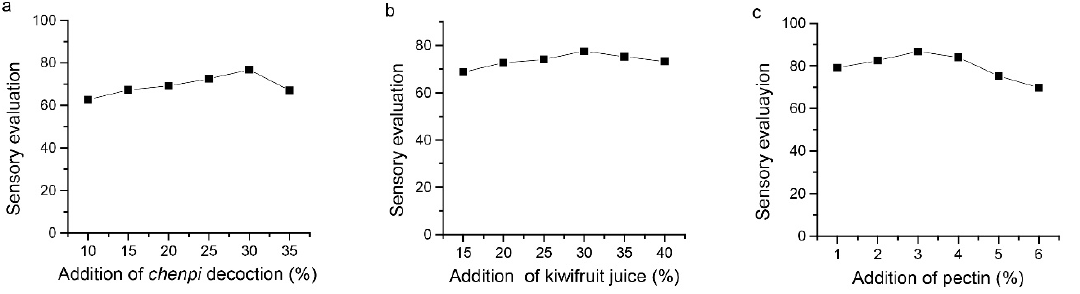
Figure 1. Effects of chenpi decoction ( a ), kiwifruit juice ( b ), and pectin ( c ) on sensory evaluation of